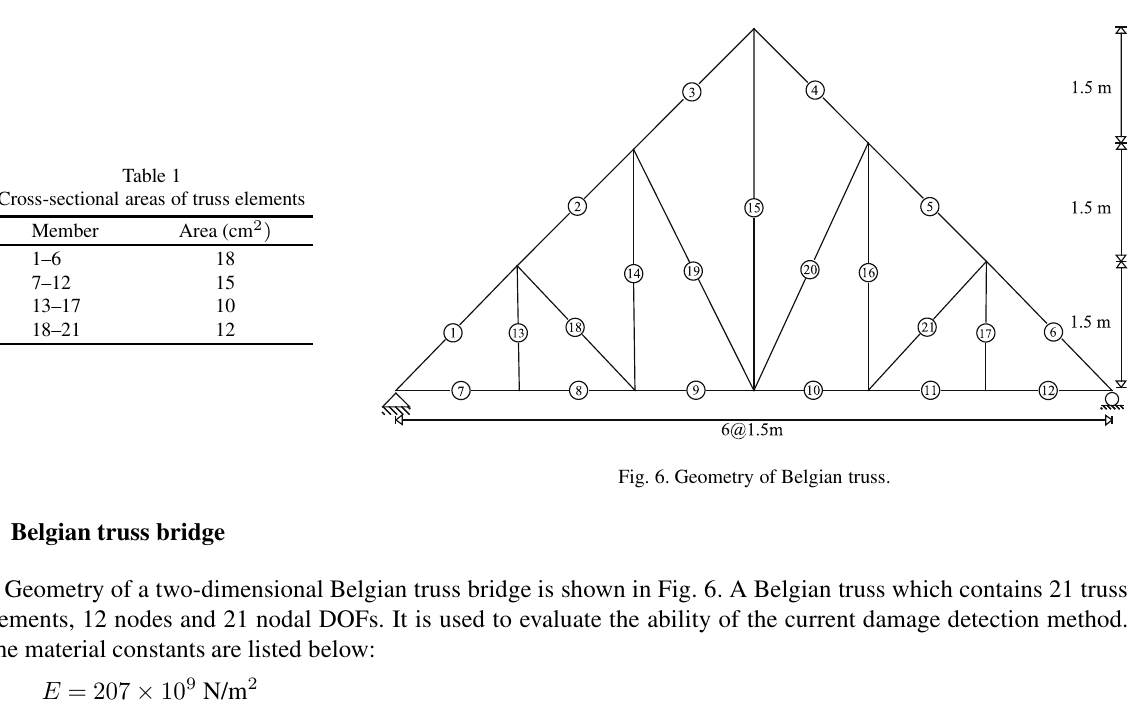
Fig. 5. Damage distribution of continuous beam using the complete and incomplete modal data in Scenario 3.